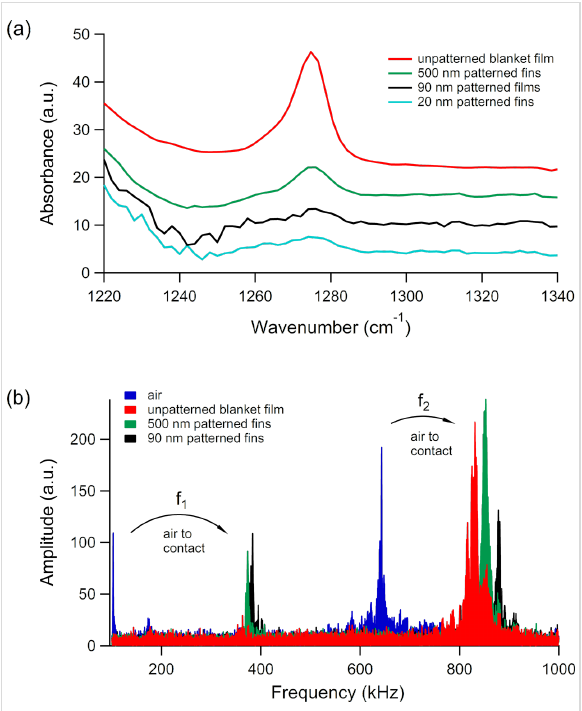
Figure 2: (a) Transmission FTIR and AFM-IR spectra of the symmet- ric SiC–H 3 deformation mode from a nanoporous organosilicate unpat- terned film and patterned fins (widths of 500 nm, 90 nm, and 20 nm), respectively. (b) CR-AFM spectra at 60 nN applied force of the first two eigenmodes from the same unpatterned film, 500 nm fins, and 90 nm fins that were measured in (a). The arrows indicate the frequency shifts of the two eigenmodes from air to